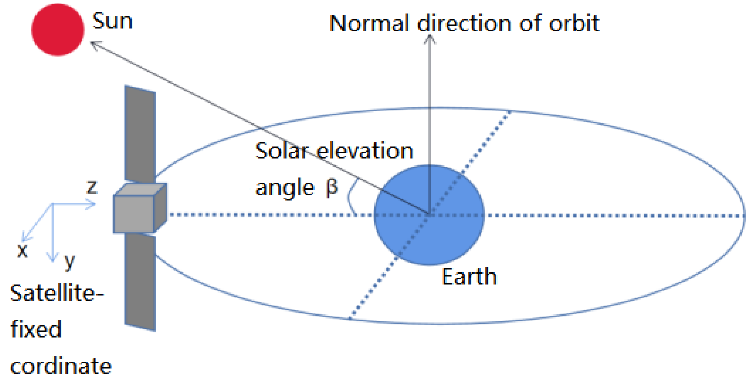
Figure 5. Schematic diagram of yaw maneuver of three-axis stabilized satellite. With the center of the mass orbital coordinate system as the benchmark, the Euler angle is used for positioning, that is, the x axis, y axis, and z axis. The x axis is the rolling axis, the y axis is the pitching axis, and the z axis is the yaw axis. When the solar altitude angle β is large, although the solar panel can rotate at a specific direction to track the sun and can meet the accuracy requirements, it cannot meet the energy supply requirements of the whole satellite.